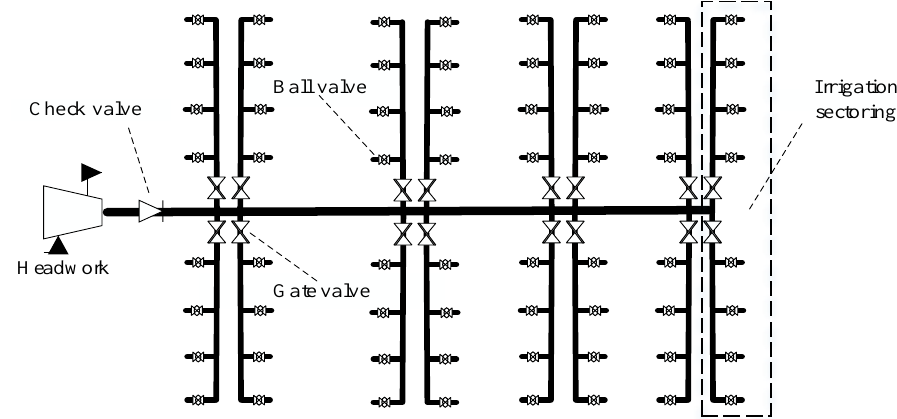
Figure 1. The schematic diagram of the branched networks and irrigation sectoring.